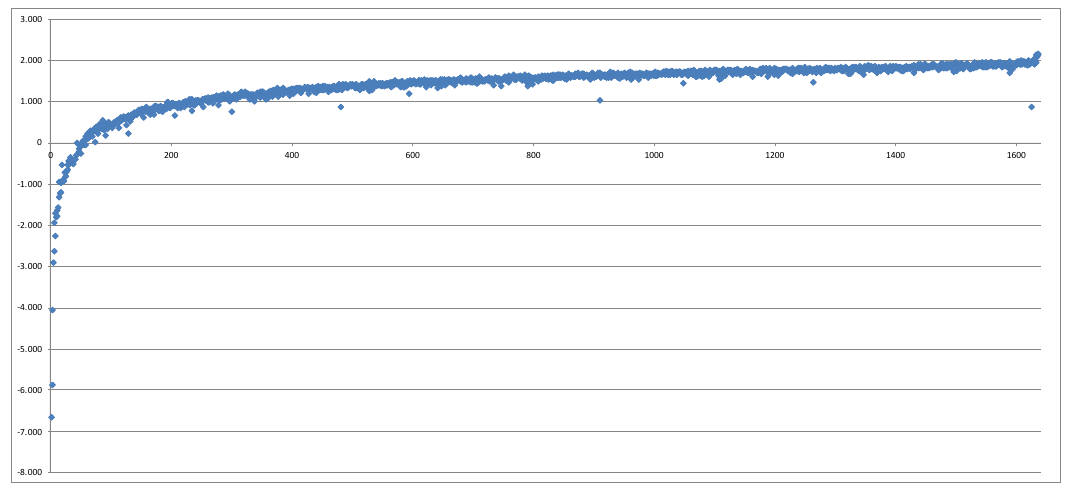
Figure 2. Nested stochastics own funds in the order of LSMC own funds w/o 1 outlier.